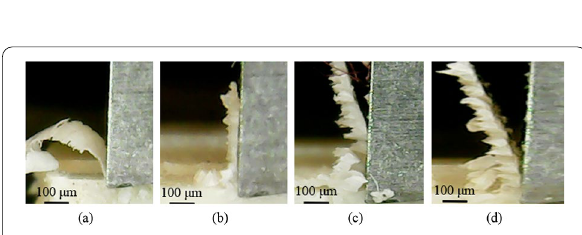
Figure 7 Chip morphologies a h and d h 130 μm in mode #1 =